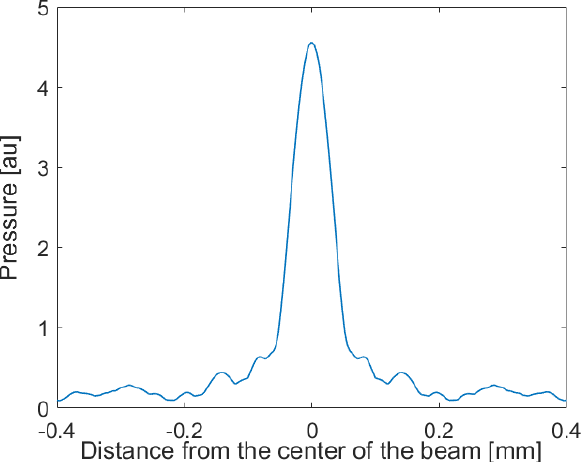
Figure 4. Transducer ultrasonic field in the focus.